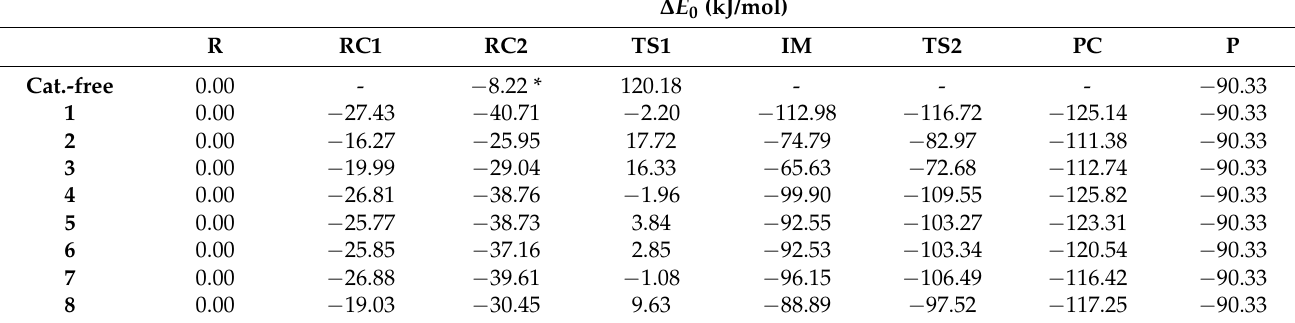
Table 1. Zero-point corrected relative energies ( ∆ E 0 ) of the reaction between phenyl isocyanate and methanol with and without catalysts, calculated using the G3MP2BHandHLYP composite method in acetonitrile, using the SMD implicit solvent model at 298.15 K and 1 atm. Cat. —catalyst,